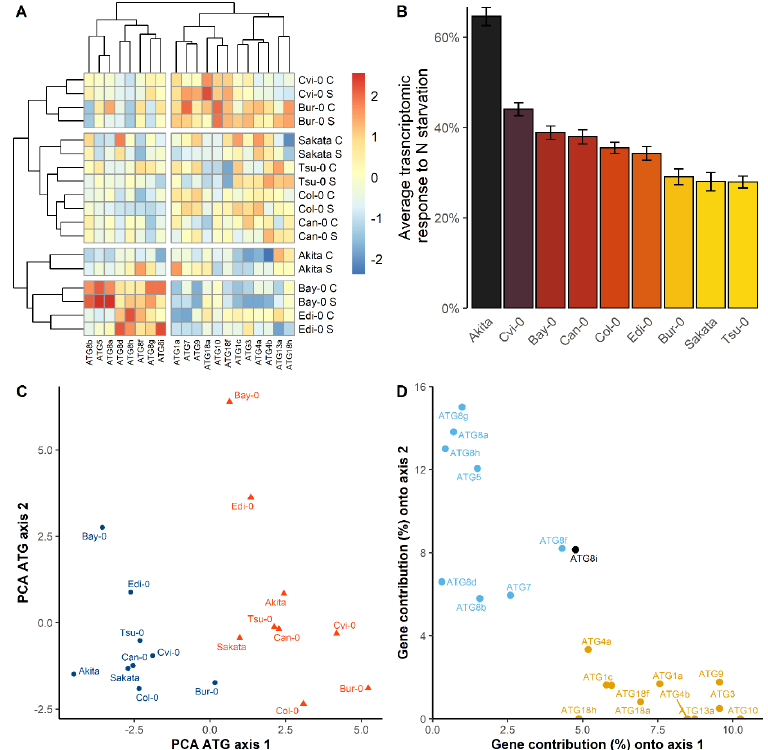
Figure 6. Classification of Arabidopsis accessions following their relative expressions of ATG genes. ( A ) Heatmap of ATG gene expressions measured in nine accessions grown in the control (c) or N starvation (s) conditions. Red and blue represented relative high or low gene expressions among genotypes. Genotypes were grouped based on the similarity of their expressions. For each condition, the matrix of gene expression was centered and scaled over all accessions. ( B ) Average transcriptomic response to N starvation of the accessions (mean ± SE) on the 22 genes. The bars are the average differences for each genotype between the expression values in the control and N starvation condition in percentage of value expression in the control condition. ( C ) PCA analysis of the expression of ATG genes. Blue dots and red triangles show the plants grown in the control and N starvation conditions, respectively. ( D ) Contribution of ATG genes to the two first PCA components. The genes contributing above 4.5% to the first, second, or both components are respectively in orange, black, or blue. PCA was run on the matrix of the expressions of the 22 ATG genes (Figure 6C). The first component explained 39.2% of the observed variation and separated well the plants growing under the two nutritive conditions (Axis 1). The second component (Axis 2) explained 23.9% and opposed mainly Bay-0 and Edi-0 from the other accessions. Twelve genes contributed to the first component. All the genes showing a strong effect of G × N interaction in ANOVA contributed to the second component (Figure 6D). On the first PCA axis, in the two nutritive conditions, Bur-0 and Cvi-0 accessions showed the highest values while Akita , Bay-0 , and Sakata , showed the lowest. Interestingly, the projected position of accession Bur-0 in the control condition on the axis 1 is close to those of